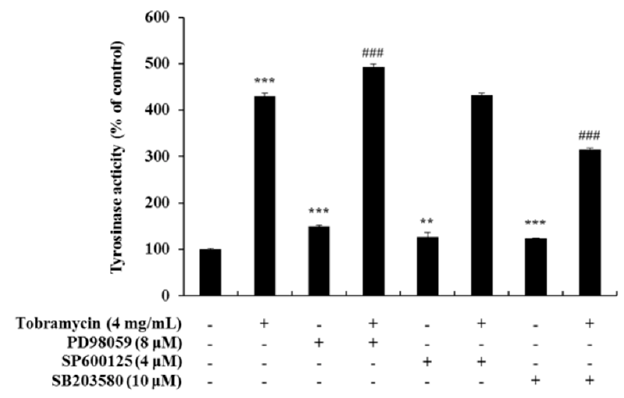
Figure 9. Effect of MAPK inhibitors on tobramycin-induced tyrosinase activity in B16F10 cells. To confirm the mechanism underlying the effect of tobramycin in melanogenesis, cellular tyrosinase activity was measured using the following MAPK inhibitors: PD98059 (ERK inhibitor), SP600125 (JNK inhibitor), and SB203580 (p38 inhibitor). Results are expressed as percentages of the control. Data are presented mean ± SD of four independent experiments ( n = 4). ** indicates p < 0.01 *** indicates p < 0.001 vs. untreated cells and ### indicates p < 0.001 vs. tobramycin treated cells.